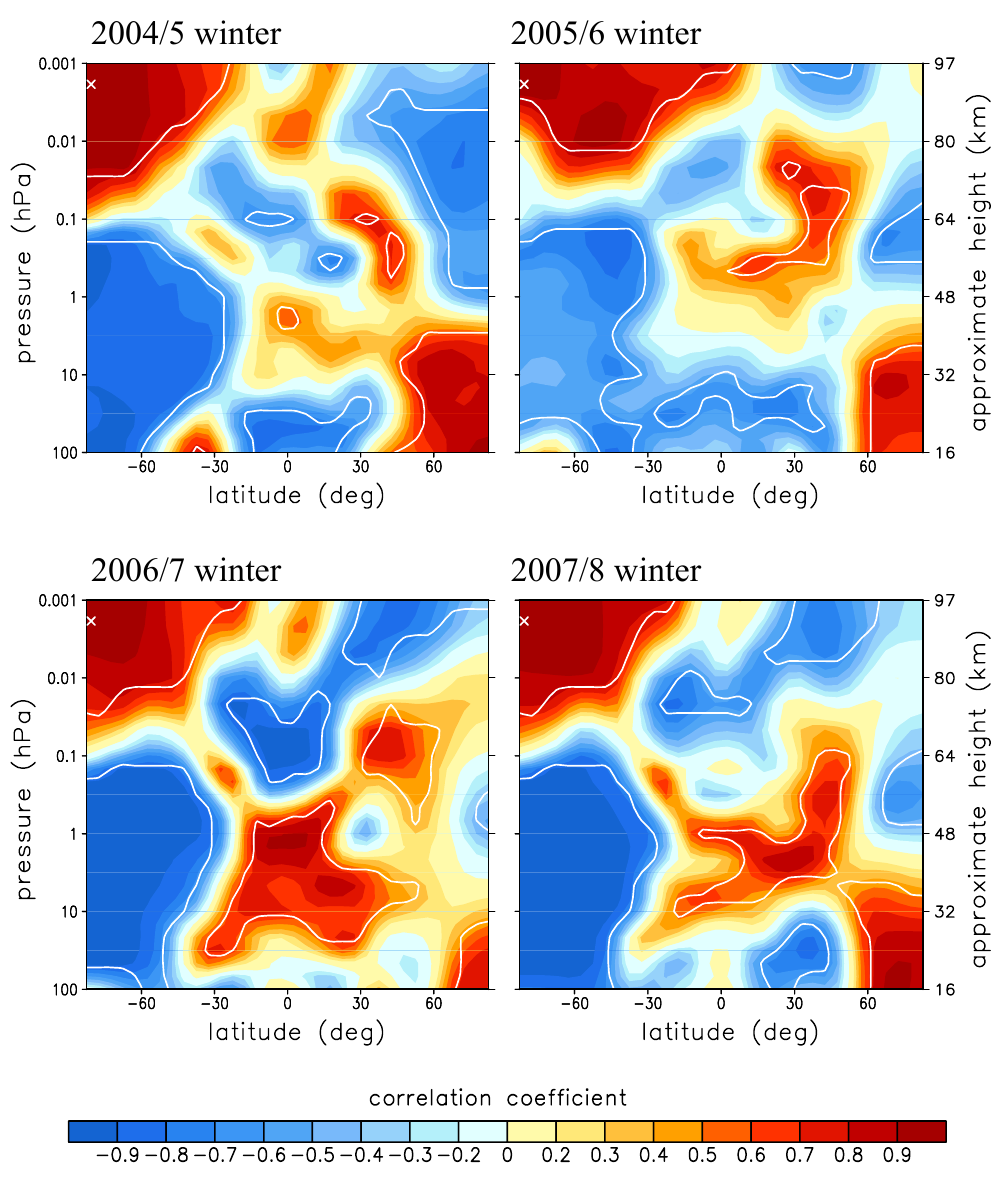
Fig. 11. Correlation coefficient for daily zonal mean temperature at each latitude/pressure with respect to the same parameter at the Antarctic summer polar mesopause ( ∼ 0.002hPa, 80–85 ◦ S, position marked with a “ × ”). The correlations are based on the day-to-day variability over 2004/2005 winter (24 January to 5 March), 2005/2006 winter (26 December to 4 February), 2006/2007 winter (26 December to 5 March) and 2007/2008 winter (26 December to 5 March), respectively. The white lines indicate the 95% level of